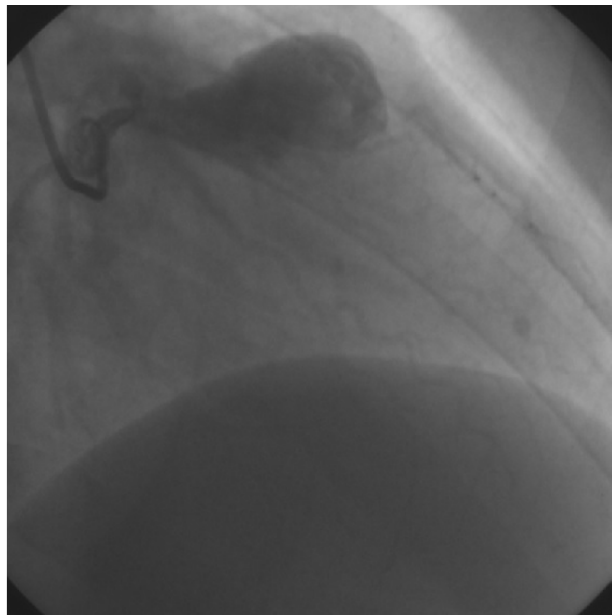
Fig. 1 - Preoperative angiographic image showing coronary artery